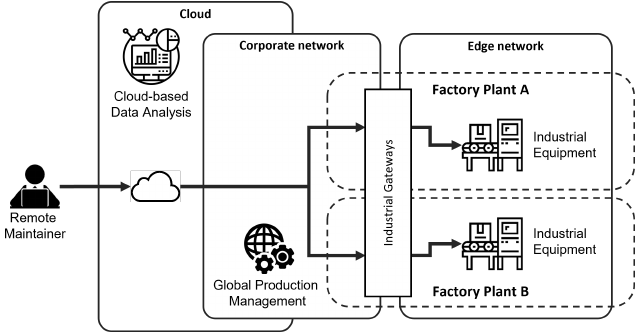
Figure 2. Secure Remote Maintenance